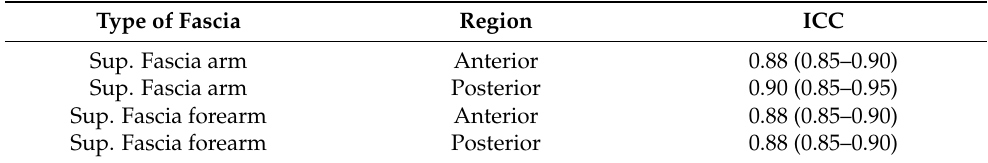
Table 9. Intra-rater reliability of the ultrasound measurements within different regions/levels of the superficial fascia of the arm and of forearm. Sup.: